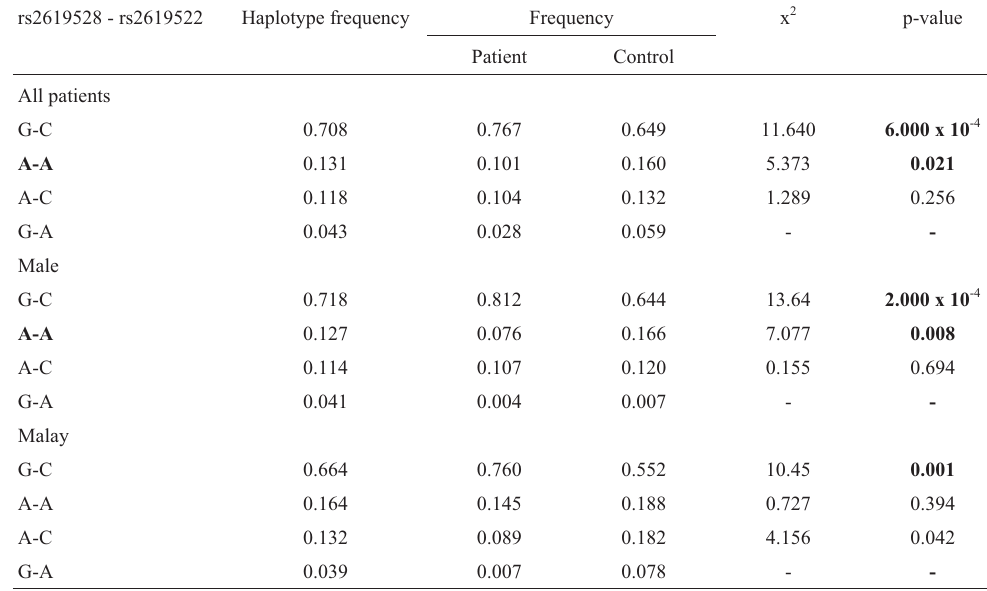
Table 7 - Haplotype analysis for